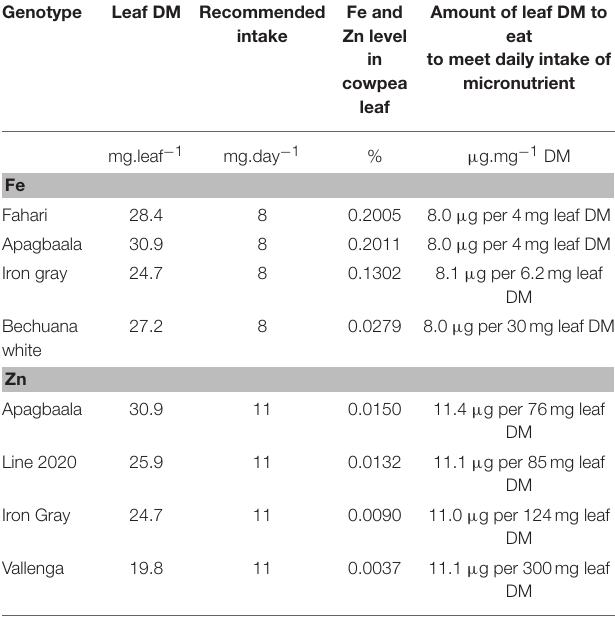
TABLE 4 | Amount of edible cowpea leaf to consume to meet the recommended daily dietary intake of Fe and Zn. Genotype